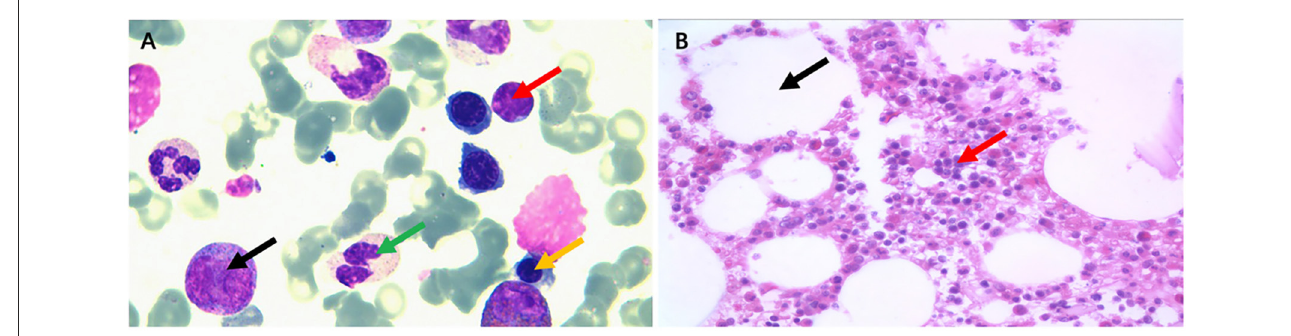
FIGURE1 The bone marrow cytology and pathological biopsy. The bone marrow cytology (A) revealed active proliferation of hematopoietic cells including granulocyte, erythroid, and megakaryocyte lineages (black arrows point to promyelocytes, green arrows point to mature granulocytes, yellow arrows point to the immature red blood cells in the middle and late stages, and red arrows point to mature lymphocytes). (B) The biopsy of the bone marrow showed that myeloproliferation is normal and hematopoietic tissue is 50% (black arrows indicate adipose tissue and red arrows indicate hematopoietic tissue).